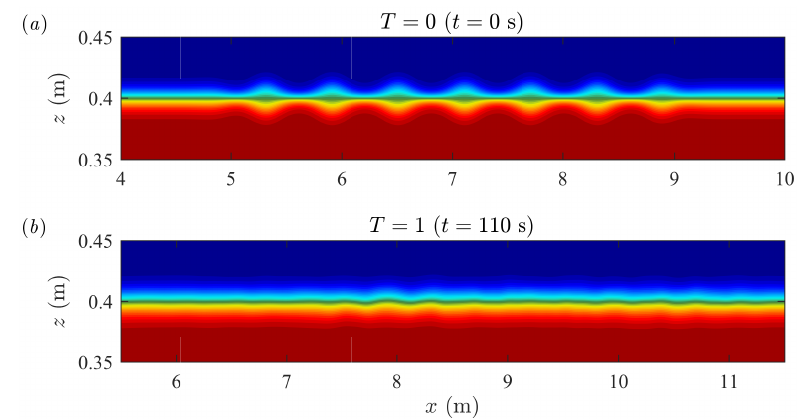
Figure 8. Detailed density contours showing the mode-2 wave packet (a) before and (b) after the collision with the solitary